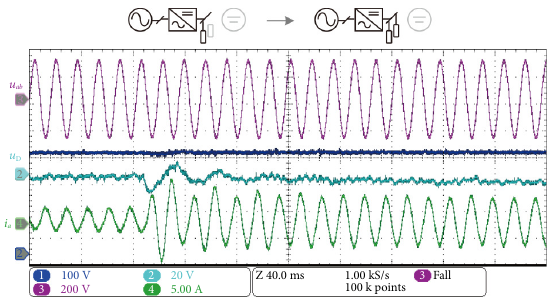
Fig. 9 Load step response in the ac dominant mode with Udc-f equilib-